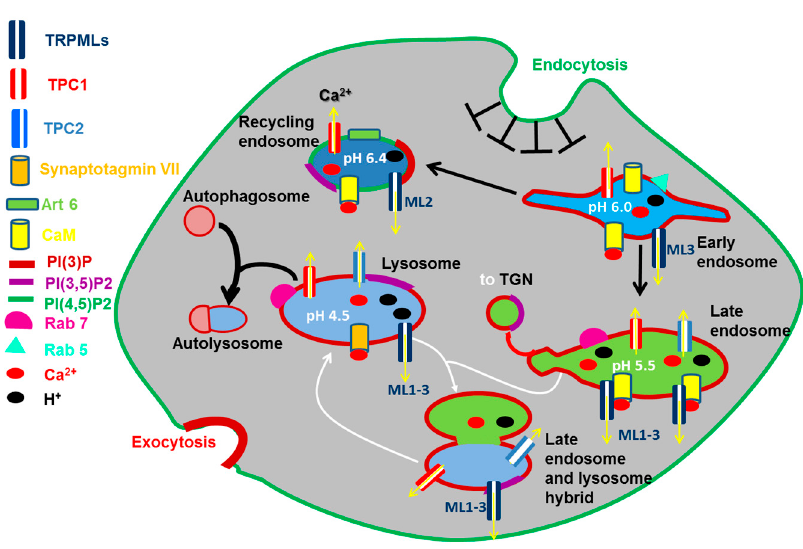
Figure 2. TRPML1-3 and TPC1-2 in the endocytic pathway. Endosomal vesicles undergo cargo-dependent maturation (black arrows), membrane fusion (white arrows), and fission/budding (red arrow). The molecular identity of each intracellular compartment is defined by specific recruitment of small G proteins (Rab and Arf GTPases) and the composition of phosphoinositides (PIPs). Endolysosomal compartments are featured by a weak-to-highly acidic pH, which has therefore been indicated for each organelle. Many steps of the endocytic pathway are Ca 2+ -dependent due to the involvement of specific Ca 2+ -dependent decoders, such as calmodulin (CaM) and synaptotagmin VII (Syt), and Arf6. All the abbreviations are indicated on the left, with the exception of TGN (Trans Golgi Network).